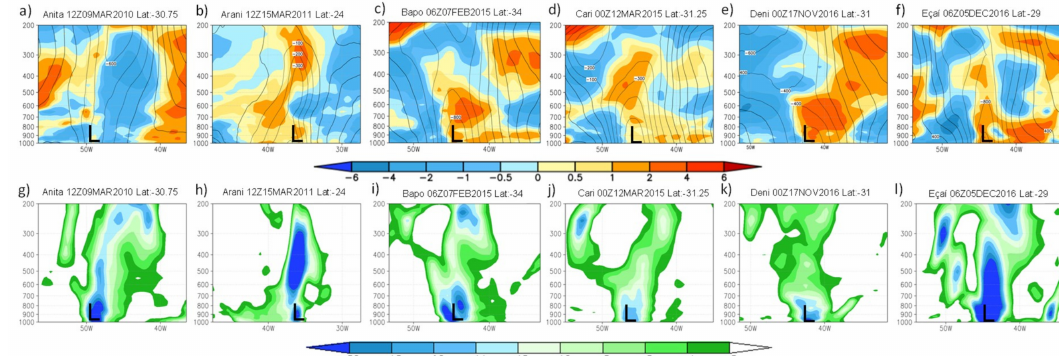
Figure 9. Top: vertical cross-section of zonal departure of air temperature ( ◦ C, shaded) and geopotential height (m, black lines). Bottom: vertical cross-section of cyclonic relative vorticity ( × 10 − 5 s − 1 ) for cyclone maturity phase: ( a , g ) Anita, ( b , h ) Arani, ( c , i ) Bapo, ( d , j ) Cari, ( e , k ) Deni, and ( f , l ) Eça í . Zonal departure was computed considering 10 ◦ east–west from the cyclone center. L indicates the cyclone